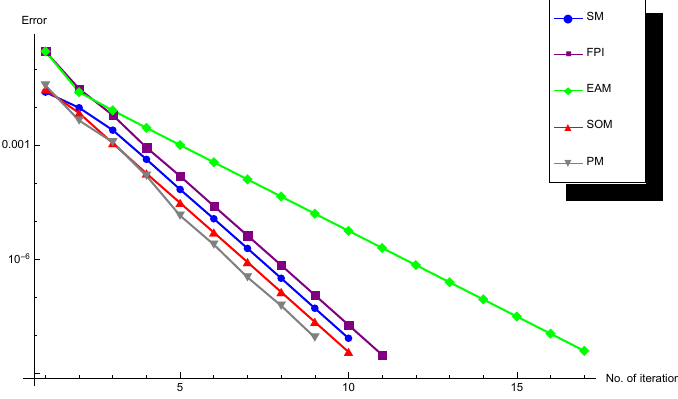
Figure 2. Convergence history for Example